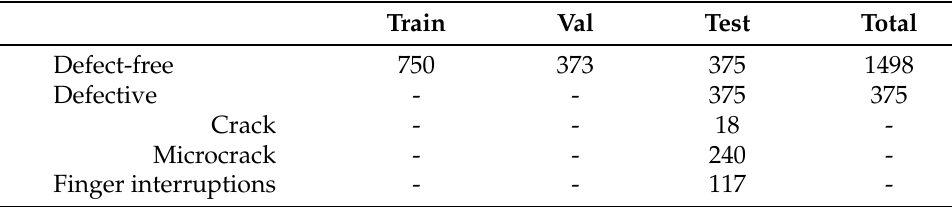
Table 2. Dataset sample distribution for unsupervised part experiments. Train Val Test